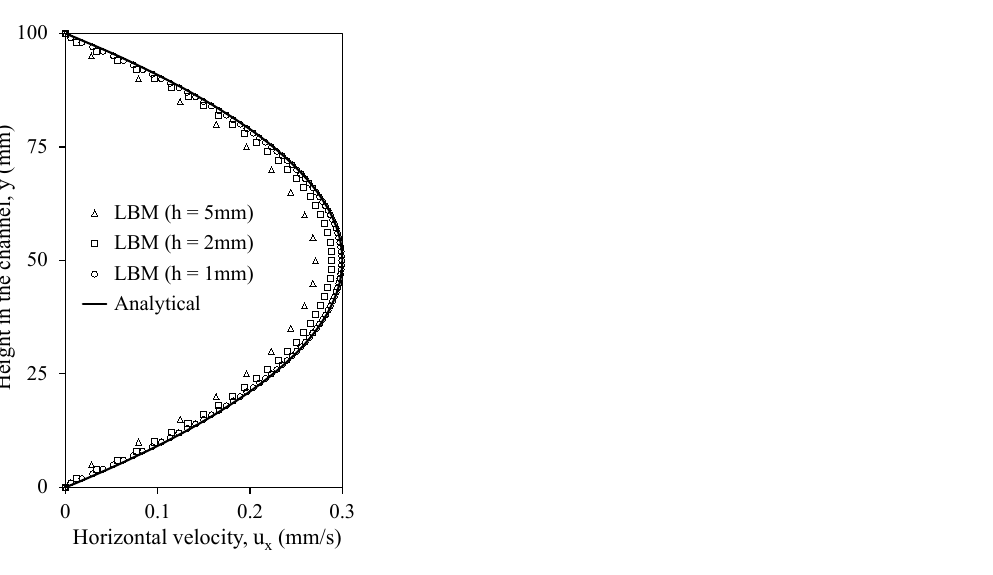
Figure 4. Simulation results for pressure-driven Poiseuille flow by using different lattice spacings in comparison to the analytical results, when Reynolds number equals one (Re = 1).